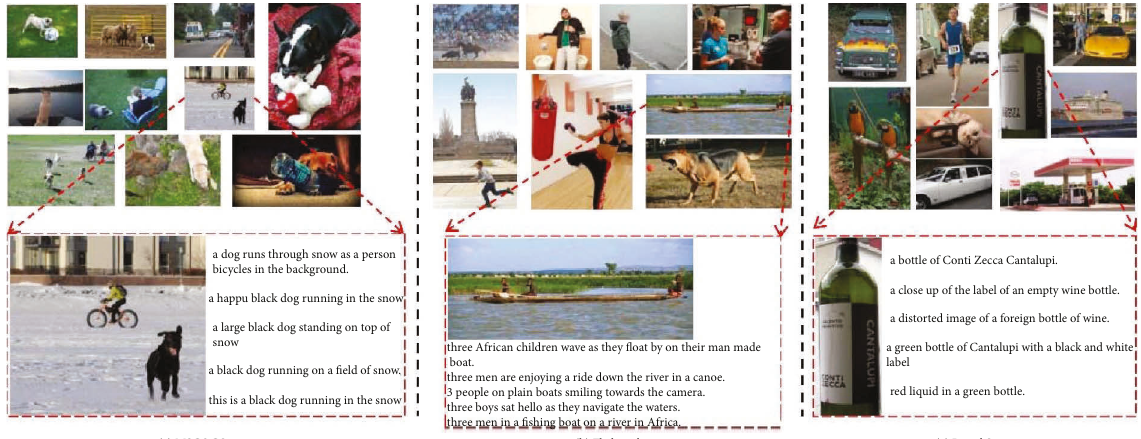
Figure 5: Sample images in the three